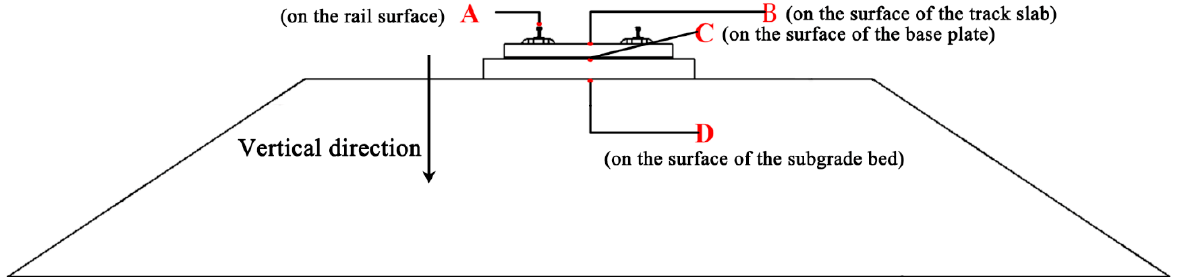
Figure 17. The layout of cross-section measuring points.